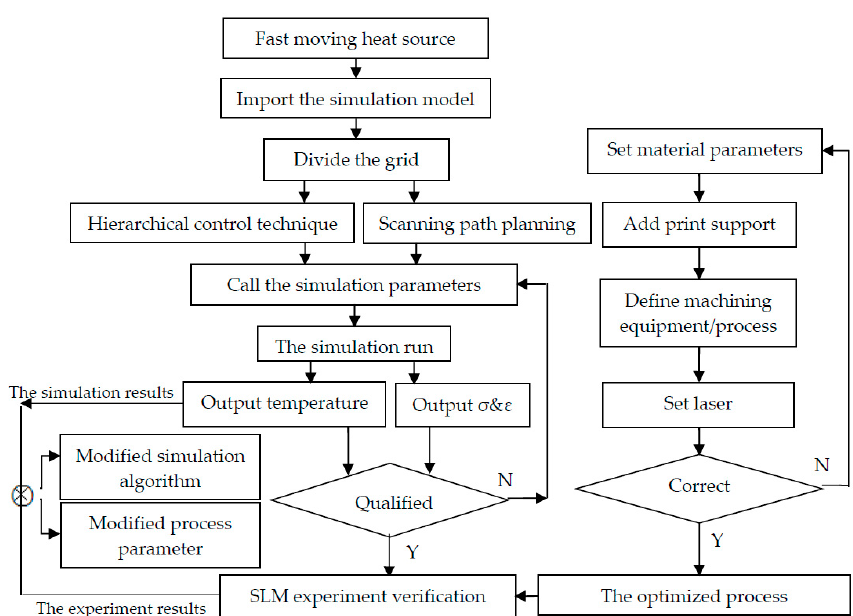
Figure 2. Simulation development flow chart.